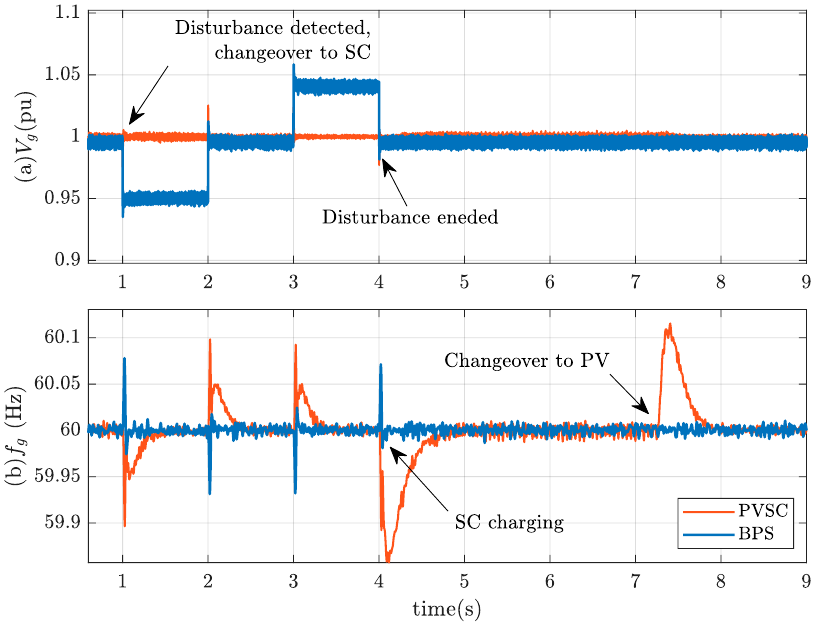
Figure 23. Performance evaluation of the proposed PVSC compared to the basic PV system during voltage disruption in the main grid: ( a ) VSC output voltage, ( b ) VSC output frequency.